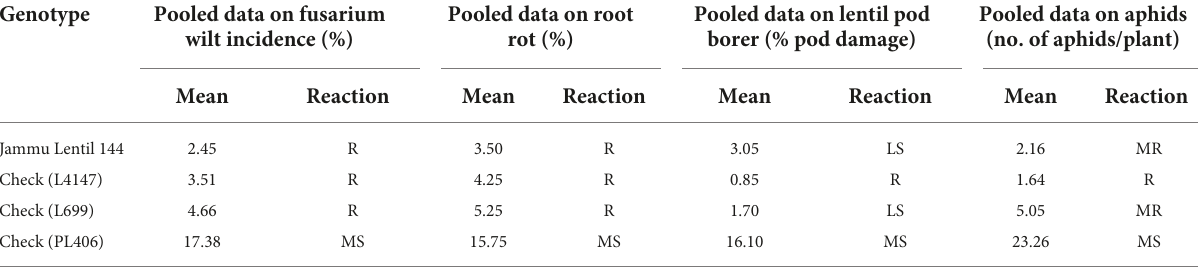
TABLE 6 Screening of selected derivative Jammu Lentil 144 against major biotic stresses during winter seasons of 2016–2017, 2017–2018, and 2018–2019. Genotype